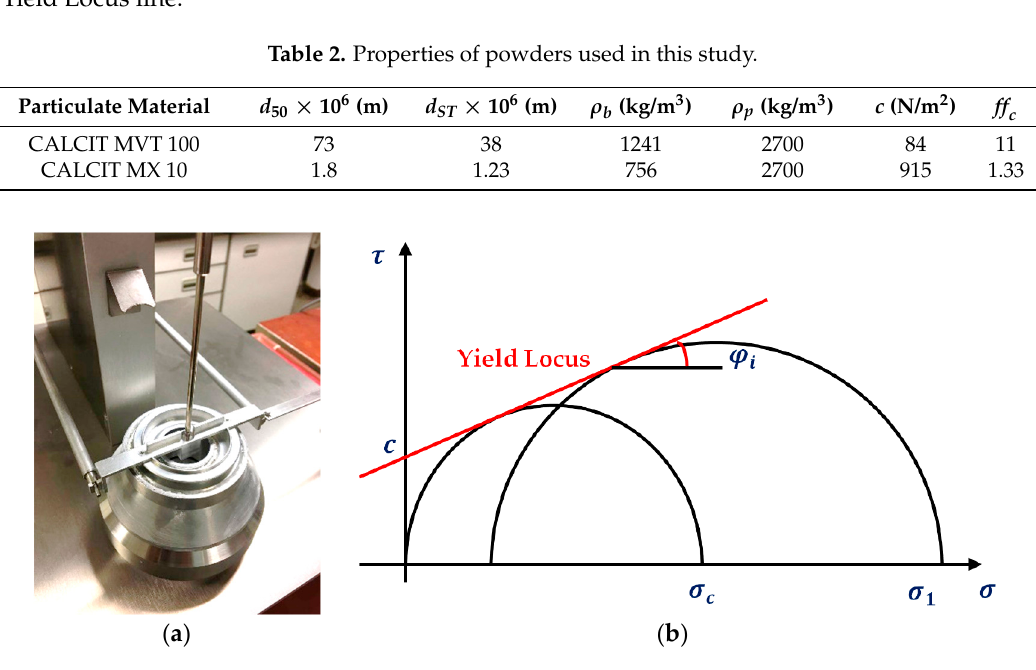
Table 2. Properties of powders used in this study.